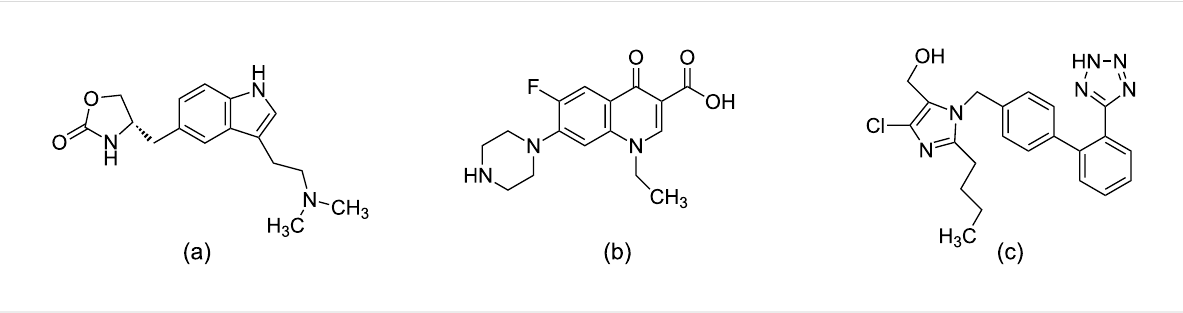
Figure 9: A few drugs discovered with the help of ligand-based drug discovery tools. (a) Zolmitriptan: used as a treatment to migraine (b) Norfloxacin: used in urinary tract infections and (c) Losartan: used to treat hypertension.